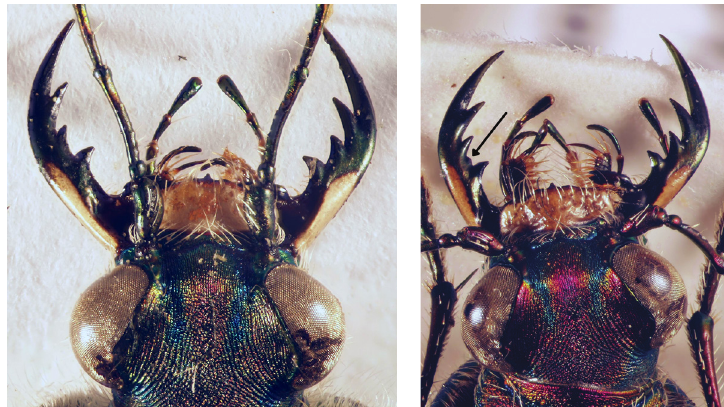
Figure 52. Head of Calomera littoralis winkleri : with regular form of left mandible (left) and a small fourth tooth on the inner side of left mandible (arrow, right).